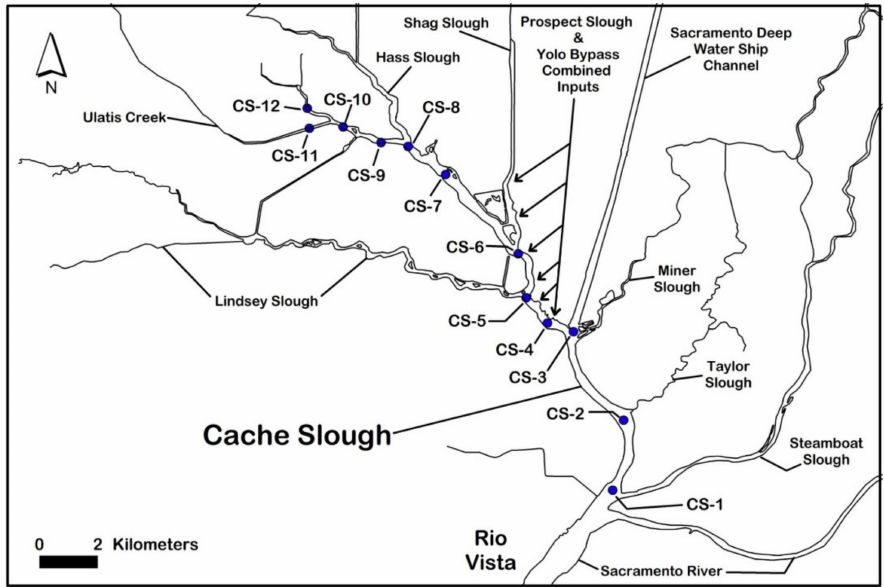
Figure 1. Twelve Cache Slough sites sampled during the spring and fall of 2012, 2013, and